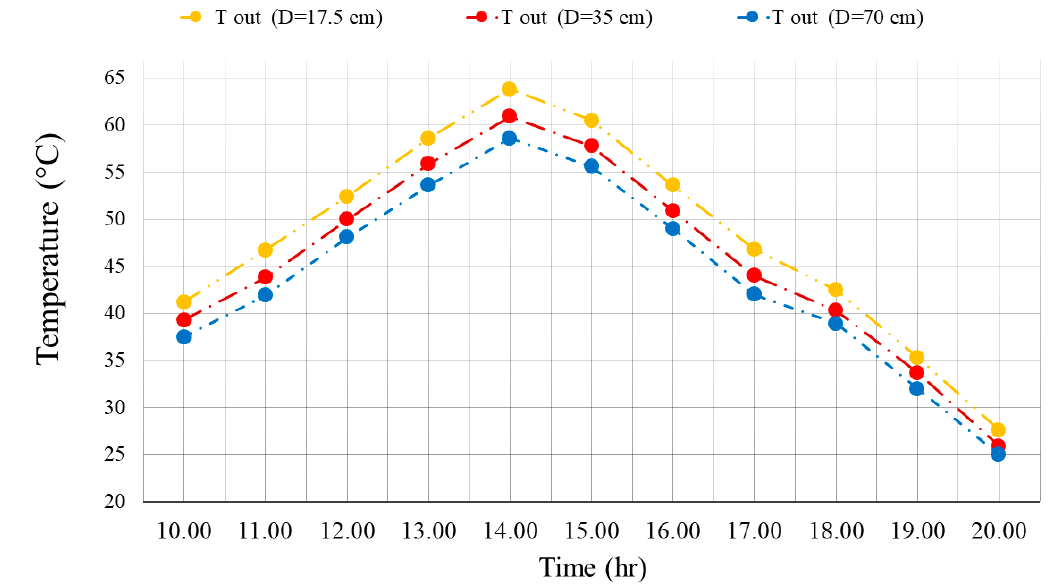
Figure 11. The effect of the size of the outlet and inlet valve on the outlet TEM of the wall for different times of the day in the presence of PCM.